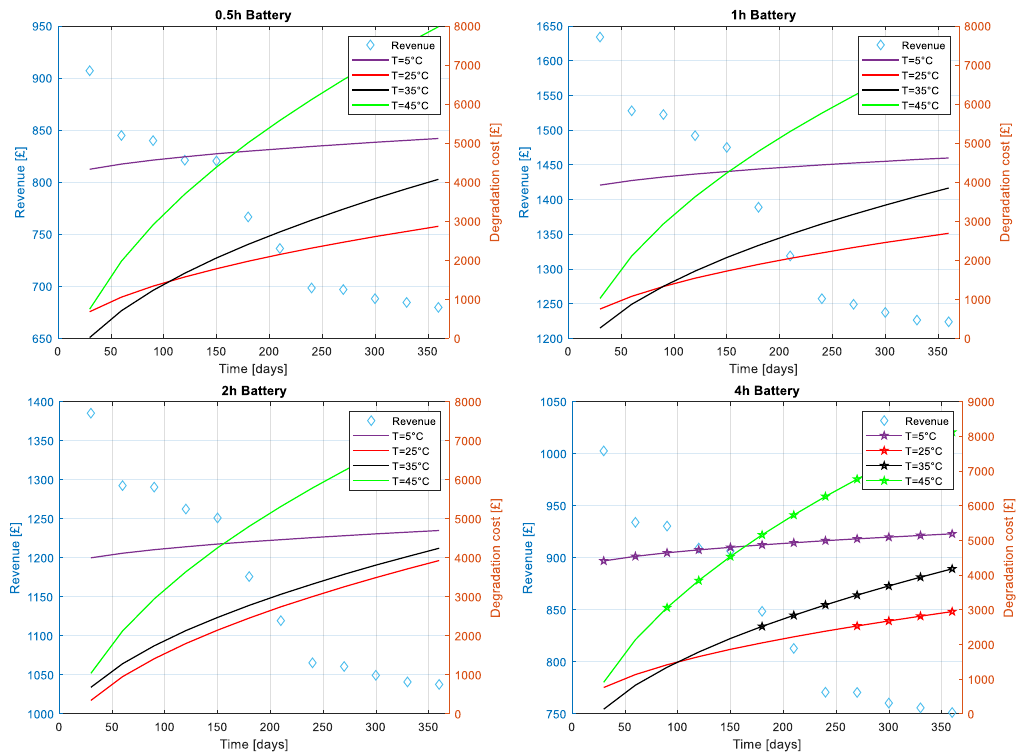
Figure 9. Revenue and degradation cost for 0.5 h - 4 h batteries for several temperatures at 100%SoC. * means a penalty is applicable on this battery at this time. Capacity fade is predicated by Formula (22).